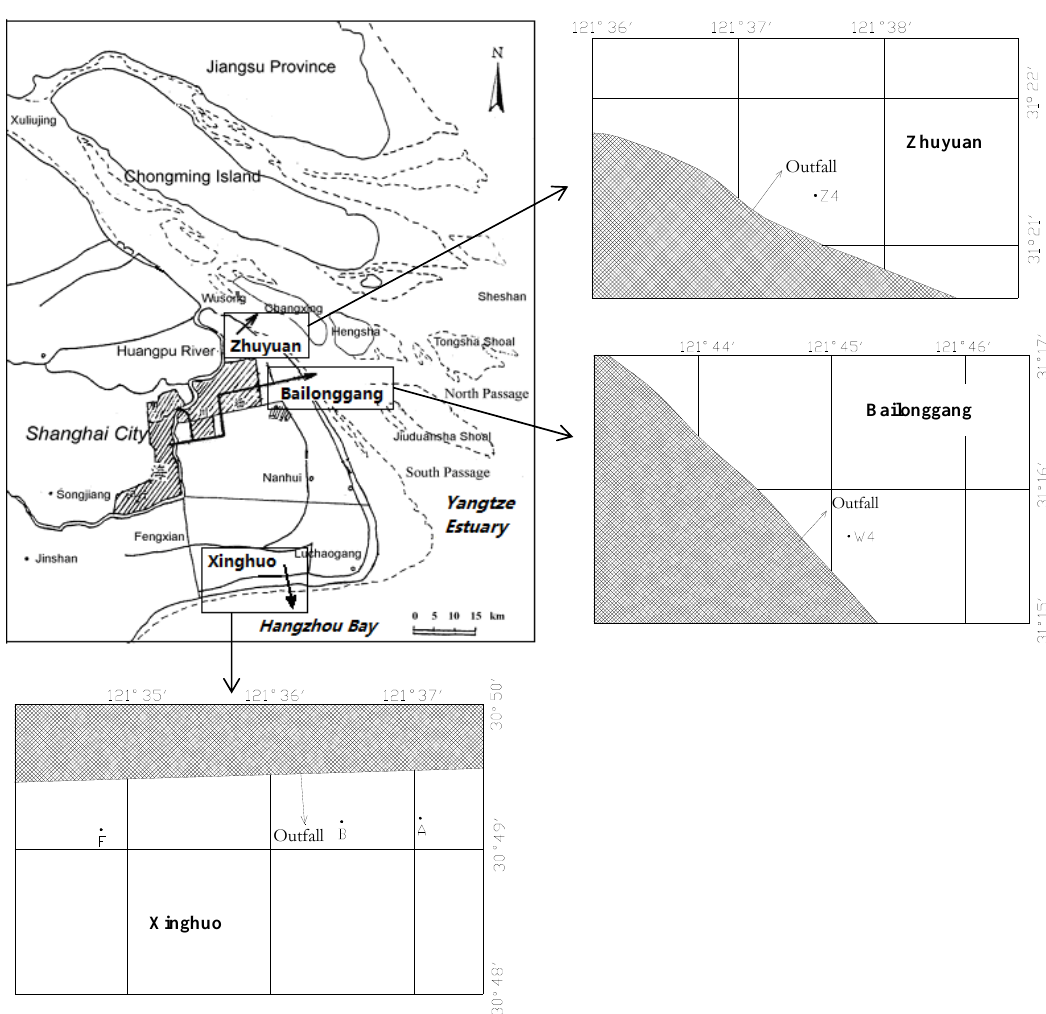
Fig. 1. Sketch map of sediment sampling site locations for the Zhuyuan, Bailonggang and Xinghuo outfalls.